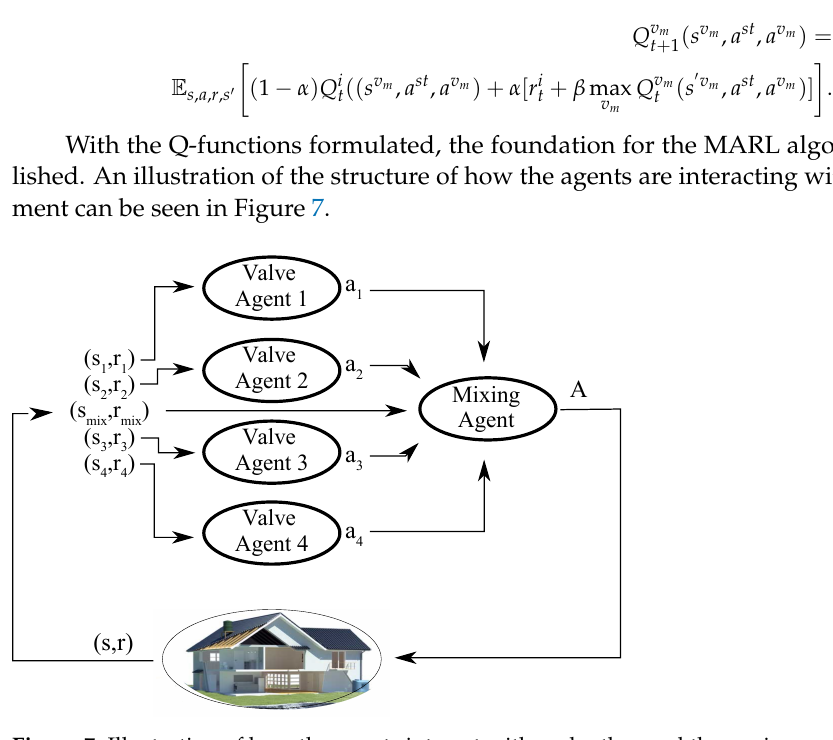
Figure 7. Illustration of how the agents interact with each other and the environment. In the figure, four valve agents, one mixing agent, and a four-zone Underfloor Heating System can be seen. The sequence of interactions is as follows; all valve agents choose an action based on the state of the environment. These actions are passed to the mixing agent, the mixing agent chooses an action based on the state of the environment and the actions of the valve agents. All actions are passed to the environment and the environment returns states and rewards for the